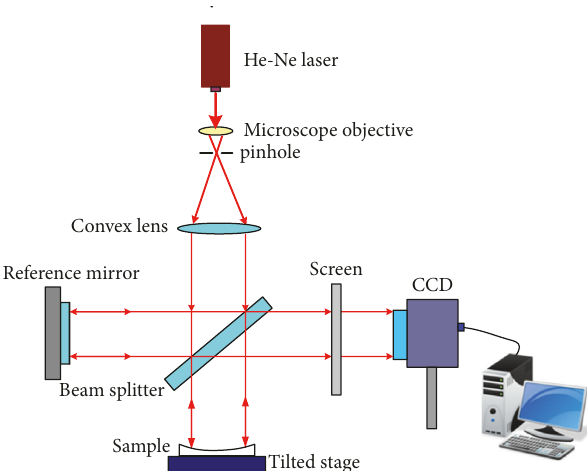
Figure 1: Stress measuring instrument based on Twyman-Green